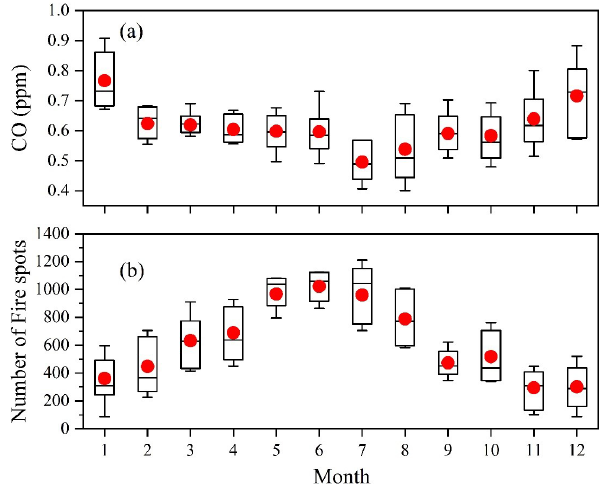
Figure 4. Average diurnal variations in CO mixing ratios from 2006 to 2015 in Shanghai, from January to December 2011 in Nanjing, from January to December 2013 in Hangzhou, and from 2006 to 2017 at the LAN station. The lines and red dots in the box are the median and mean CO concentrations at the LAN station, respec- tively; the box’s lower and upper limits represent 25th and 75th percentile concentrations, respectively; and the lower and upper whiskers correspond to the 10th and 90th percentile